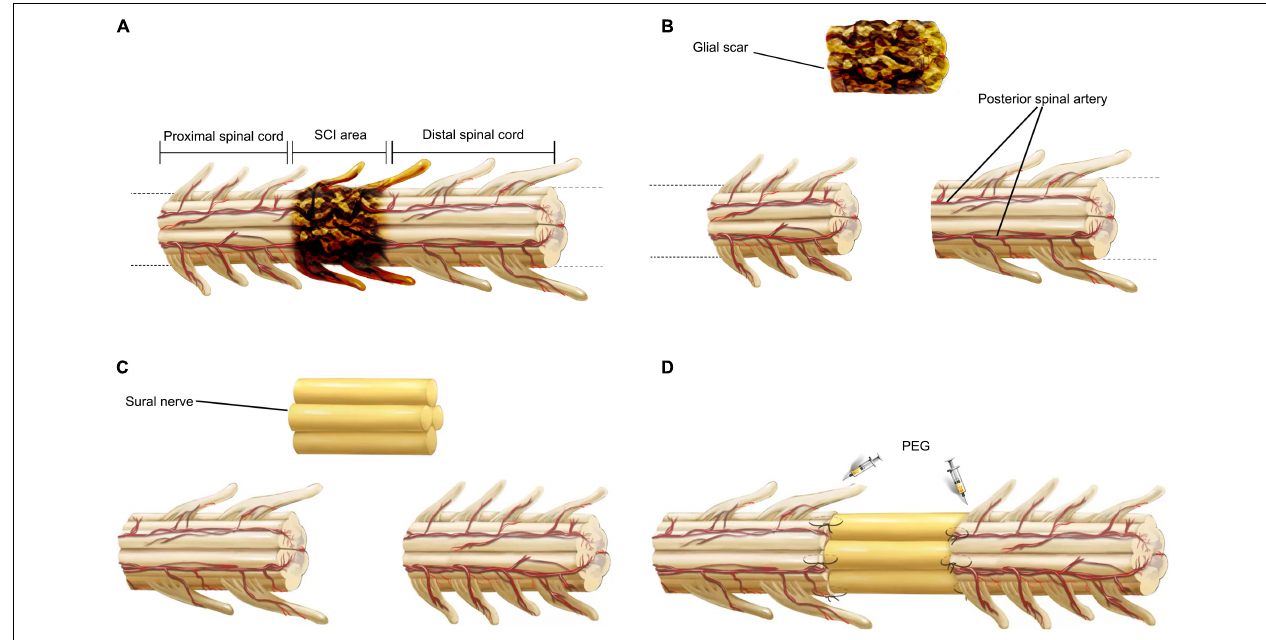
FIGURE 1 | Key surgical steps of SNT. First, the area of spinal cord injury is removed to produce two acutely transected spinal cord stumps (A,B) . Then, based on the effective length of the defect between two fresh spinal stumps, a section of sural nerve harvested from the patient’s lower leg simultaneously, was divided into several bundles, maintaining the cranial and caudal orientation of all the bundles, and sutured side by side into one bundle (C) . Finally, the sural nerve is autotransplanted to bridge the gap between the distal and proximal spinal cords. The sites of transection were topically applied with PEG to complete the SCF, and the two sites of transection are then anastomosed with suturing under the microscope (D)